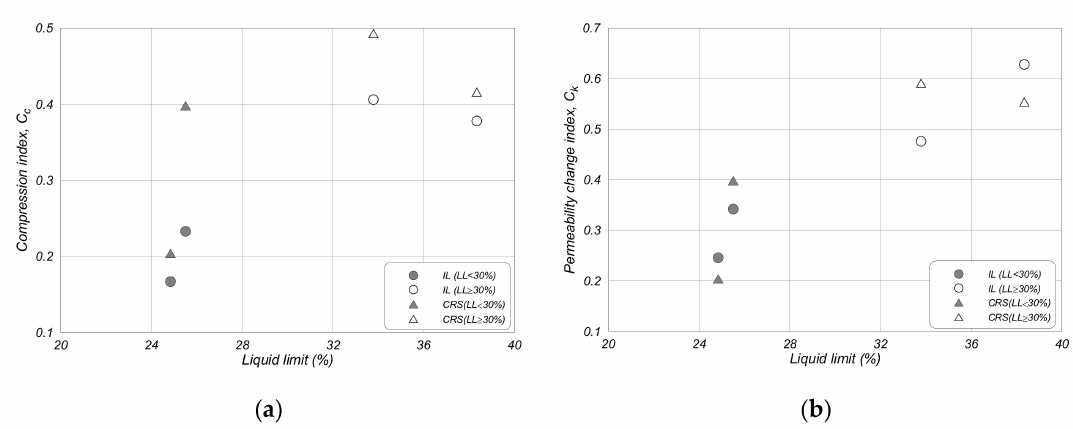
Figure 7. Consolidation properties of Incheon region soil: ( a ) liquid limit (LL)-compression index (C c ); ( b ) liquid limit (LL)-permeability change index (C k